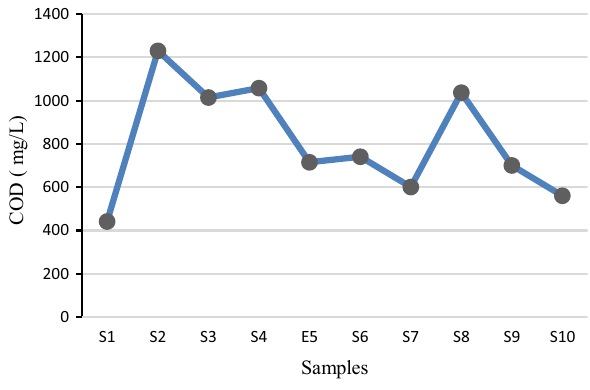
Fig. 10 The COD values of analyzed dairy effluents